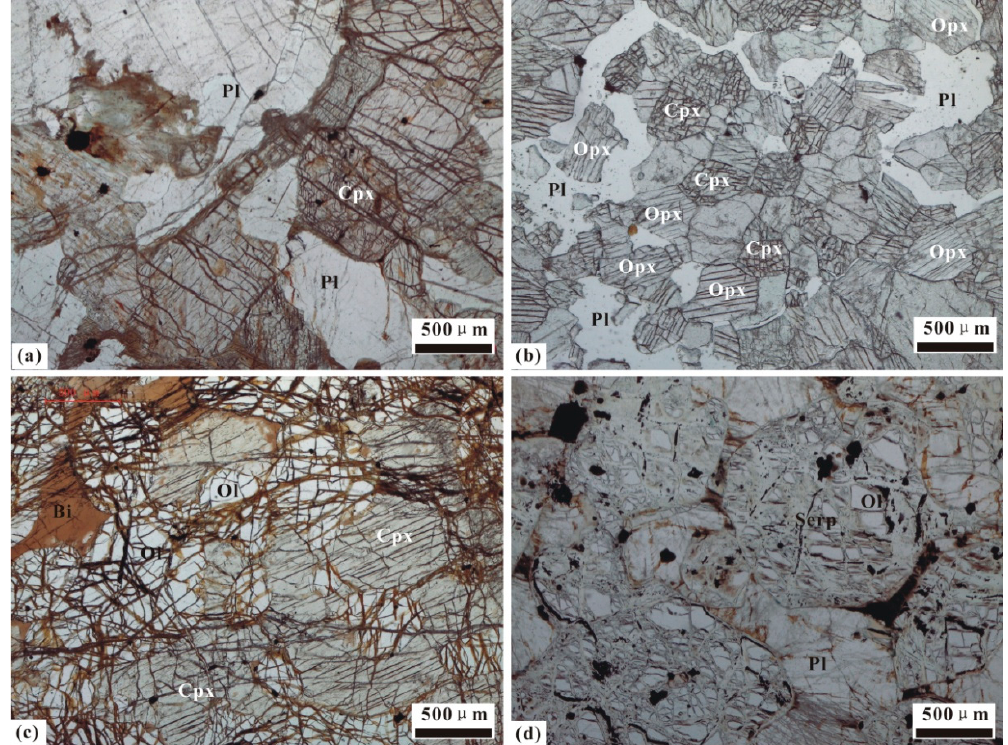
Figure 2. Photomicrographs of rocks from the Xingdi No.2 intrusion. ( a ) Plagioclase (Pl) and clinopyroxene (Cpx) showing typical gabbro texture; ( b ) euhedral-subhedral clinopyroxene (Cpx) and orthopyroxene (Opx) in pyroxenites with less plagioclase (Pl); ( c ) olivine (Ol) enclosed